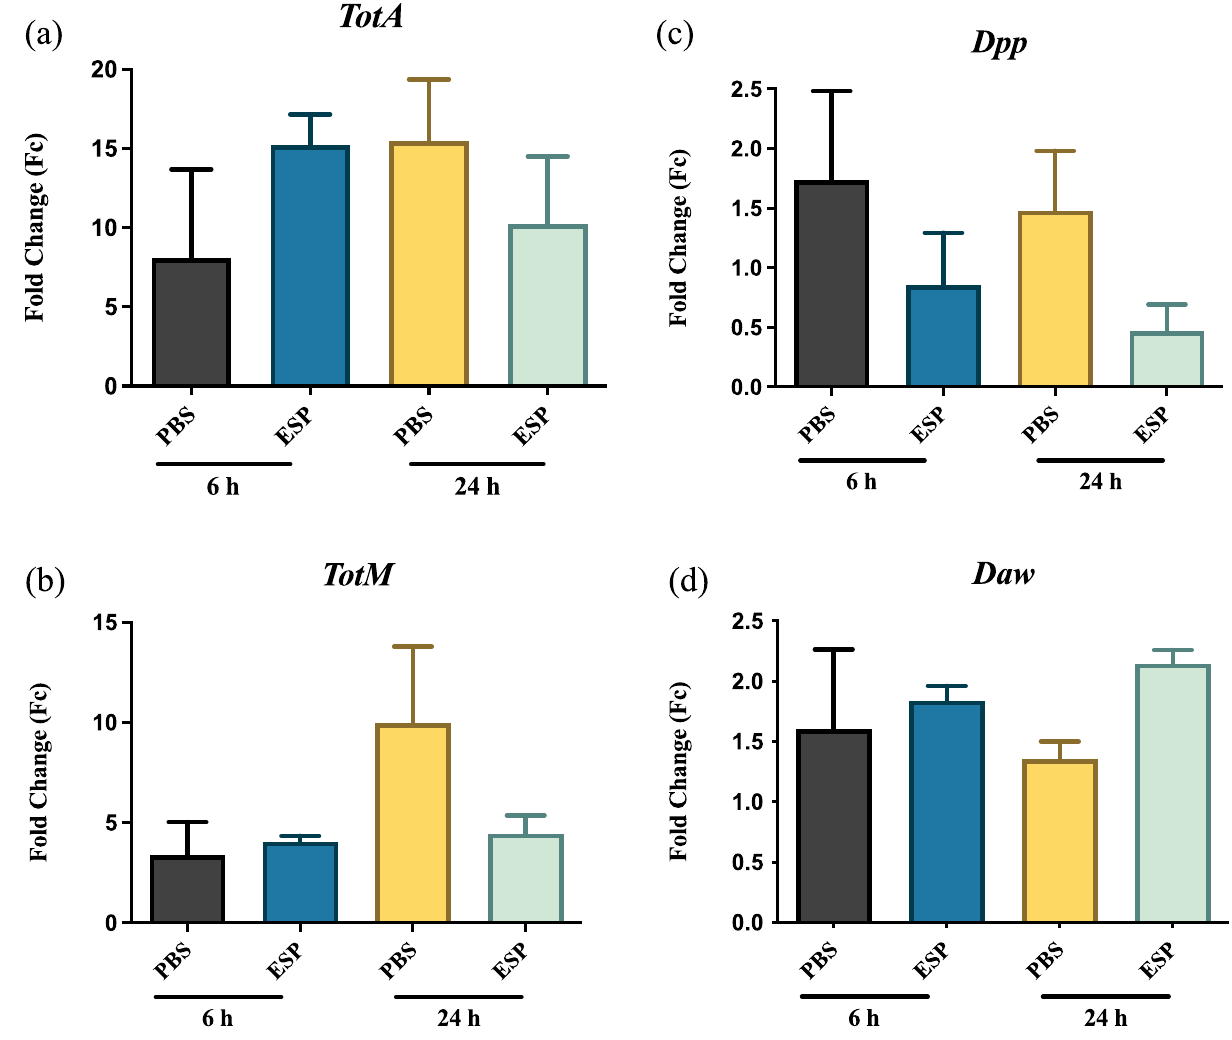
Figure 3. Expression of immune-related genes in Drosophila melanogaster injected with Steinernema carpocapsae nematode excreted/secreted products (ESPs). Oregon-R adult flies were injected with 3 ng of ESPs from S. carpocapsae nematodes or PBS as a control. Samples were collected at 6 and 24 h and following quantitative RT-PCR, mRNA values were normalized to a baseline 0-h time point and the housekeeping gene RpL32. Expression of the JAK-Stat regulated genes ( a ) TotA , ( b ) TotM , and the TGF-β regulated genes ( c ) Dpp , and ( d ) Daw Within the first 3 h after injection, males treated with nematode ESPs had a significant delay in inducing the melanization response with the PBS control group containing 39.67% and 52.67% of individuals with no or light melanization compared to 70.33% and 22.67% for males injected with the nematode products (Fig. 5b). Females had no difference in melanization between the ESP and control groups at 3 h. Although not significant, it was interesting that none of the PBS-injected males and ESP-injected males contained any individuals with a high degree of melanization within the first 3 h compared to the female flies with frequencies of 5% and 11% for the PBS and ESP groups, respectively. At 6 h post injection, neither males nor females displayed significant differ- ences in melanization between the experimental and control groups (Fig. 5c). At the 24-h time point, male flies maintained a significant difference in melanization with a higher percentage of ESP-injected individuals (52.0%) having light melanization compared to the control group (27.3%) (Fig. 5d). Likewise, there was a significant difference in the number of individuals with light melanization between males (52.0%) and females (22.67%) whereas the PBS injected males had similar frequencies to PBS injected females. By this point, male and female groups presented similar levels of high melanin pigmentation. These results suggest that D. melanogaster males have a delayed melanization response compared to female flies when challenged with S. carpocapsae ESPs. Both PBS and ESP treated males experience most of significant changes between 3–24 and 6–24 h whereas ESP treated females are more affected over 24 h compared to controls.